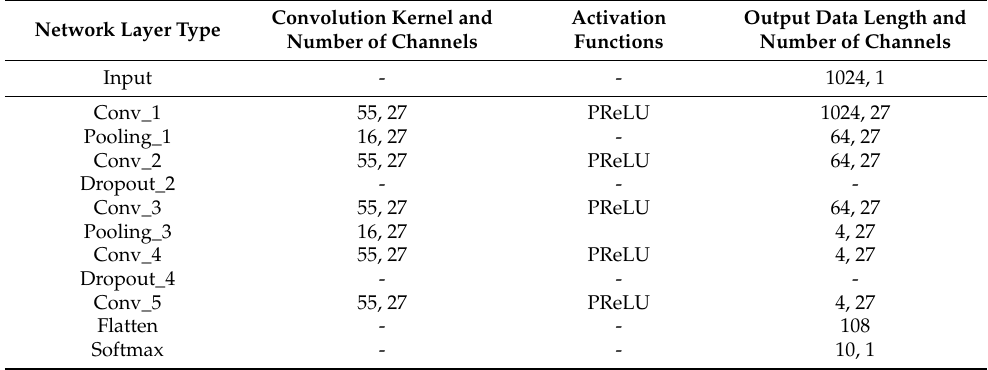
Table 1. The 1DCNN